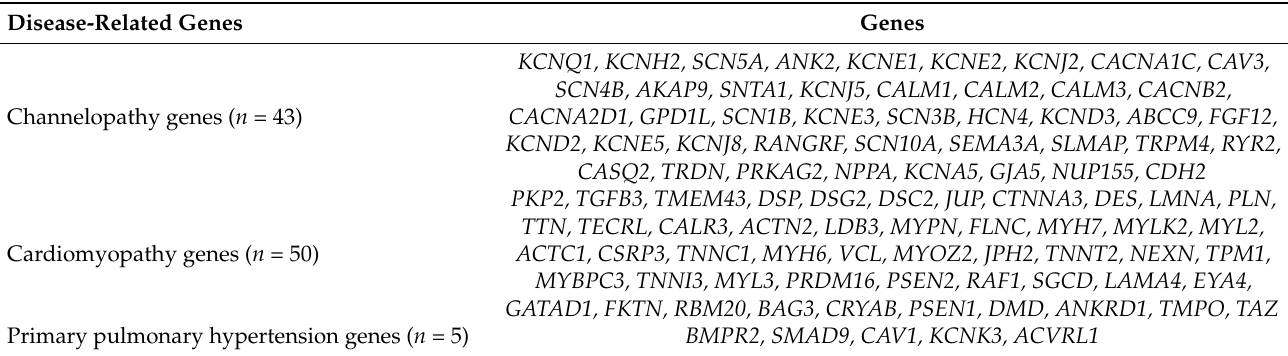
Table 1. List of cardiac syncope-related